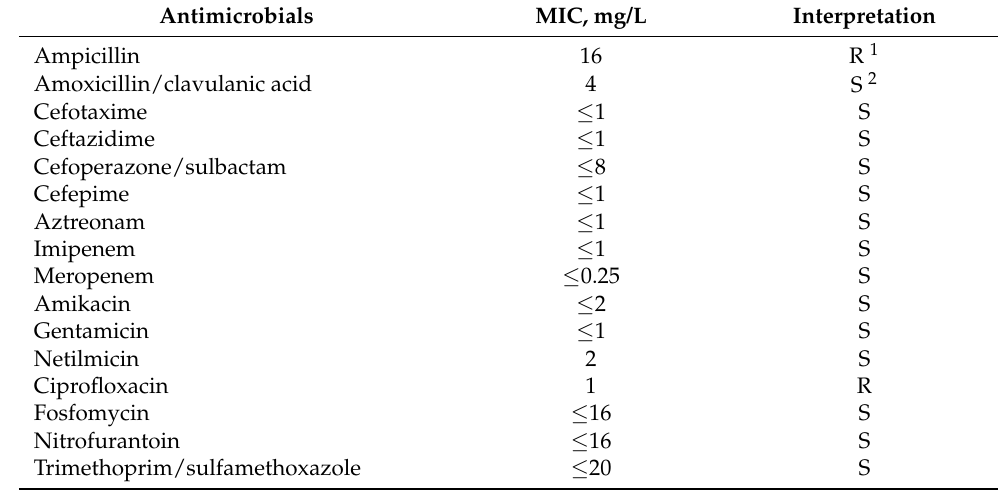
Table 1. Antimicrobial susceptibility of EAHEC strain SCPM-O-B-9427.